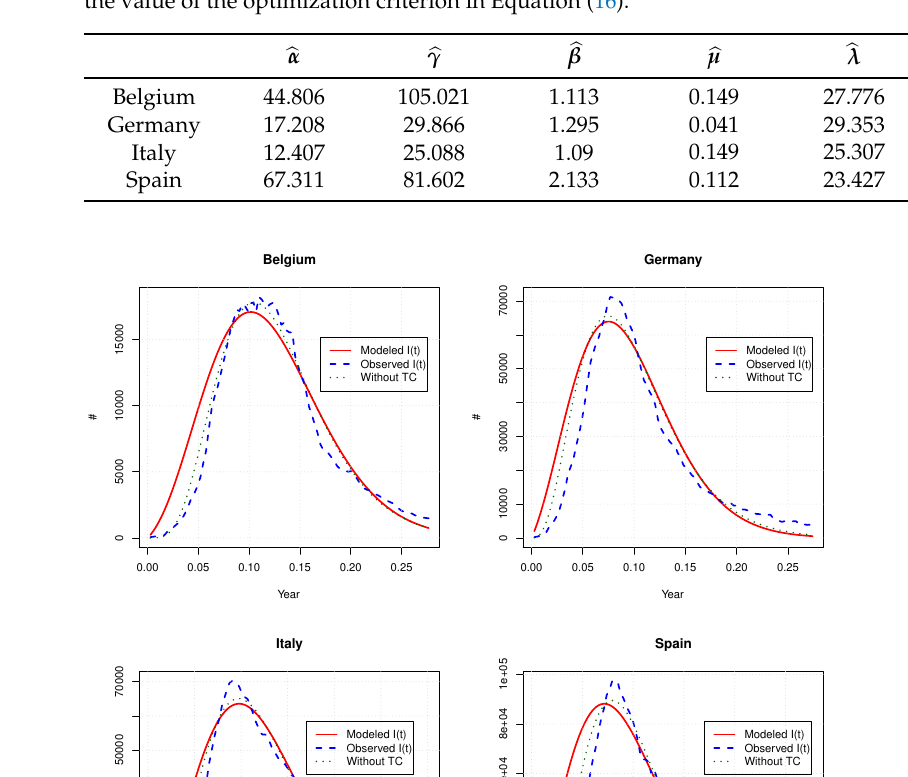
Table 6. Parameter estimates for the model ruled by Equation (19) (unit of time t : year). The SSE is the value of the optimization criterion in Equation (16).